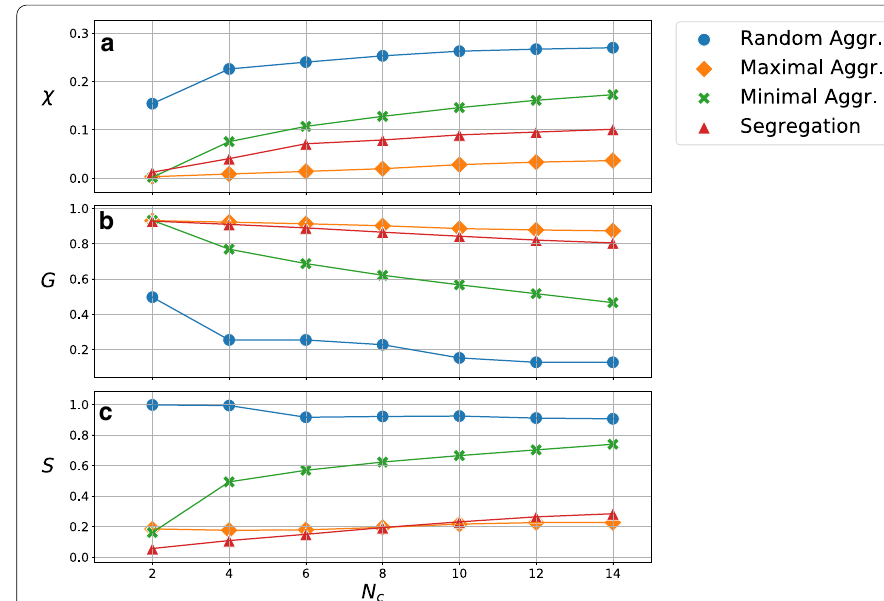
Fig. 4 Fraction of conflicts χ ( a ), relative size of the biggest connected component G ( b ), and entropy of the color distribution S ( c ) as a function of the number of colors in the network N c , for the different containment